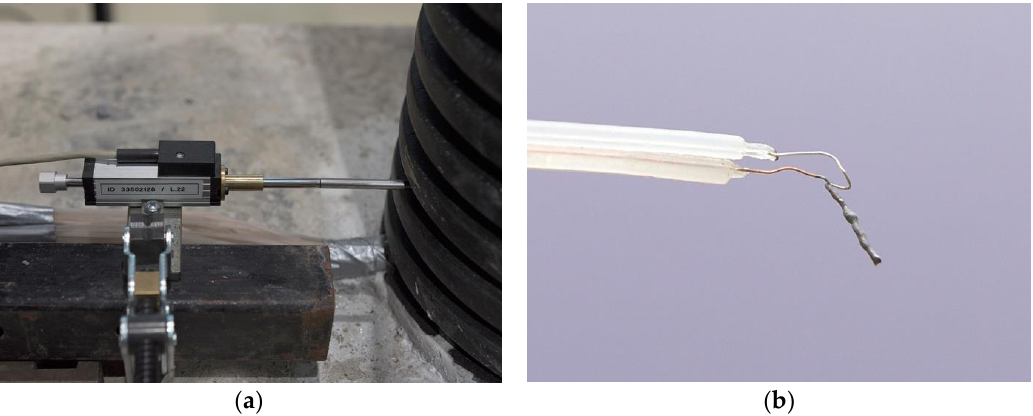
Figure 6. ( a ) A Novotechnik TR25 potentiometric position transducer; ( b ) Welded thermocouple wire.